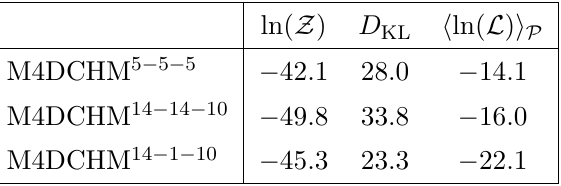
Table 6. Statistics from the combined Bayesian scans of each model, re-weighted as if the priors on the fermion parameters were